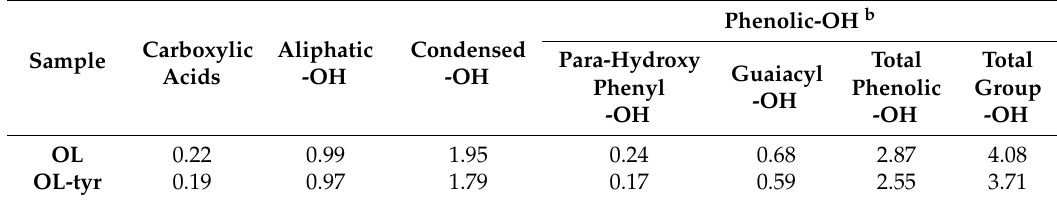
Table 1. Functional OH distribution (mmol/g) for parent OL and for OL-tyr after treatment with tyrosinase a . Phenolic-OH b Carboxylic Aliphatic Condensed Total Total Para-Hydroxy Sample Guaiacyl Acids -OH -OH Group Phenolic Phenyl -OH -OH -OH -OH OL 0.22 0.99 1.95